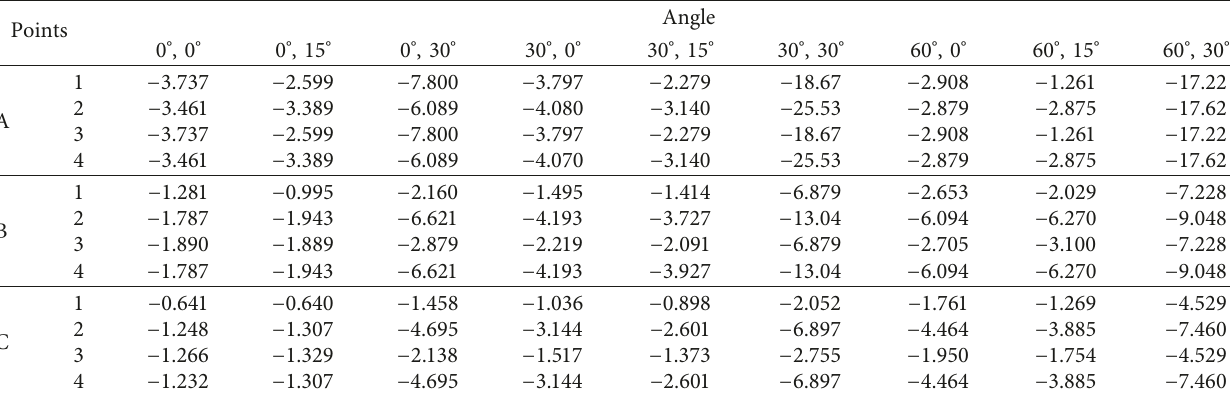
Table 5: Minimum principal stress